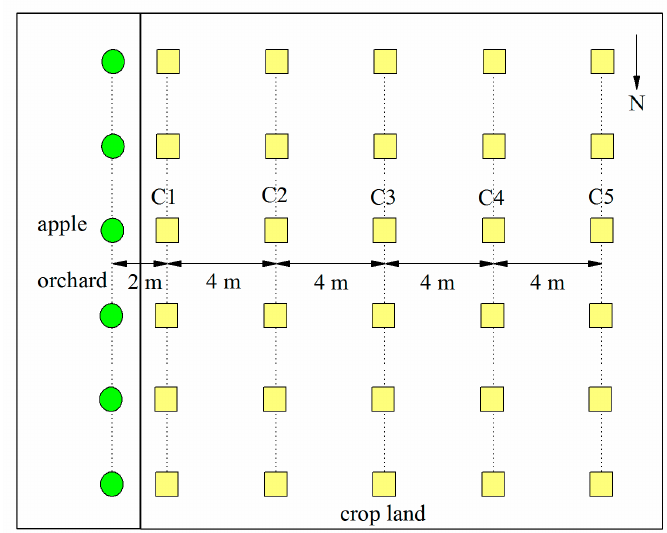
Figure 2. The layout of the soil moisture monitoring sites.